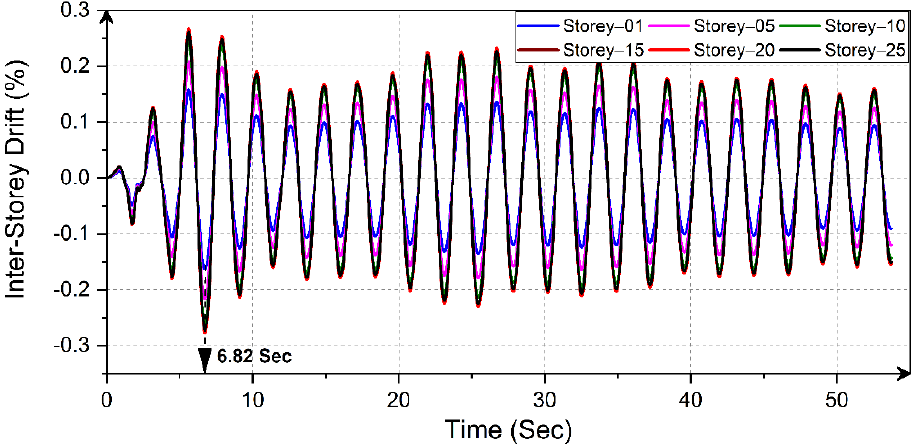
Figure 8. The time–history plot of the inter-story drift for various floors of the building resting on RP – Mats.